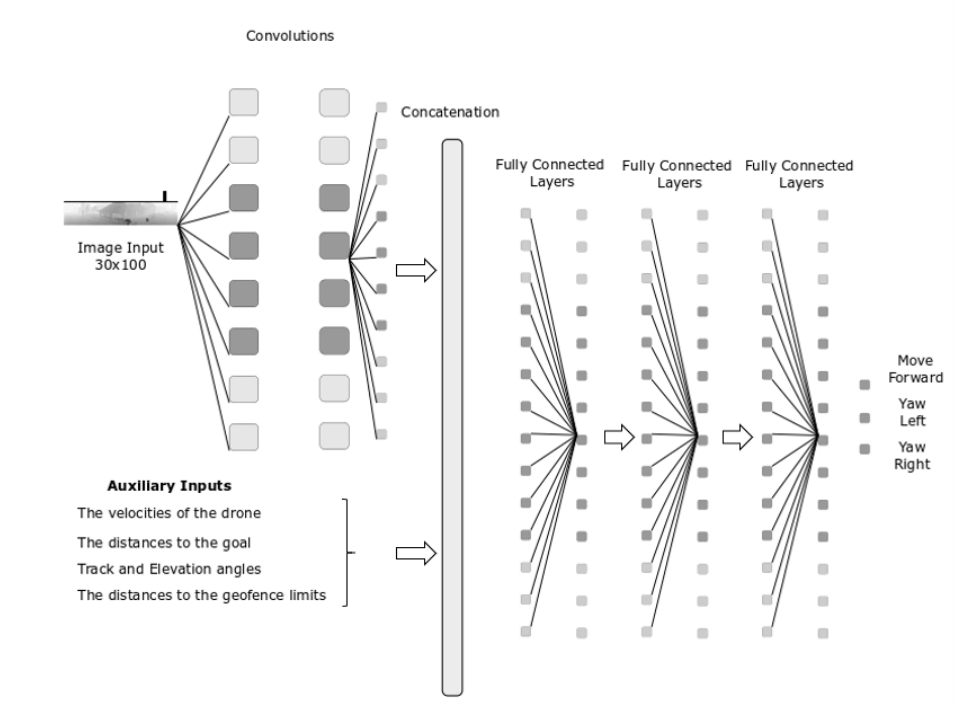
Figure 8. The Agent.